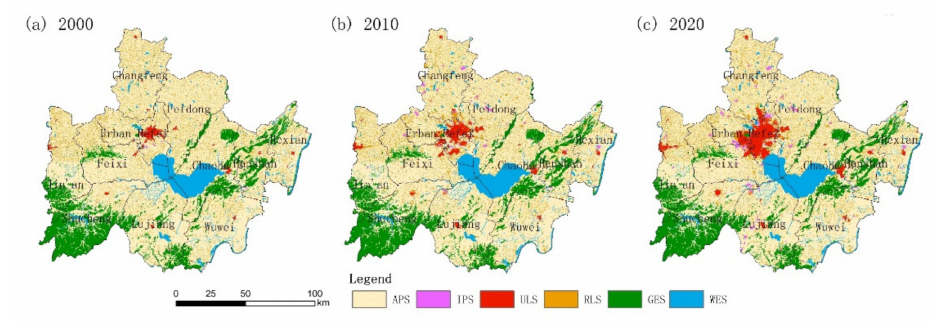
Figure 4. The Pattern of PLES in the Chaohu Lake Basin in 2000 ( a ), 2010 ( b ), 2020 ( c